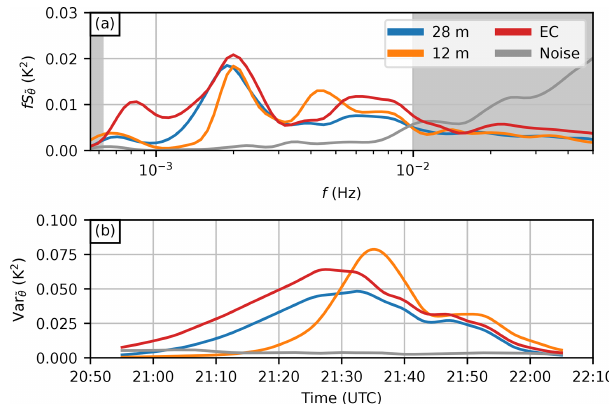
Figure 10. Wavelet analysis for the event on 27 January 2020. (a) Wavelet-derived temperature spectral energy density for DTS ˜ θ from two heights and for EC T s . (b) Corresponding band-passed wavelet variance of temperature, including variance contributions from only the unshaded area of (a) . Five-minute running-average smoothing has been applied in (b) . The noise is the estimated aver- age DTS noise at the two